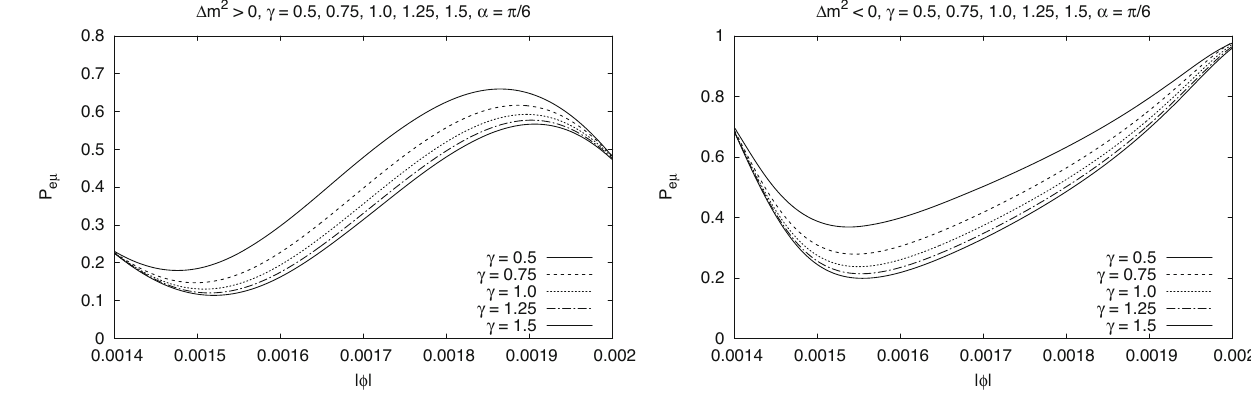
Δ m 2 > 0, γ = 0.5, 0.75, 1.0, 1.25, 1.5, α = π /6